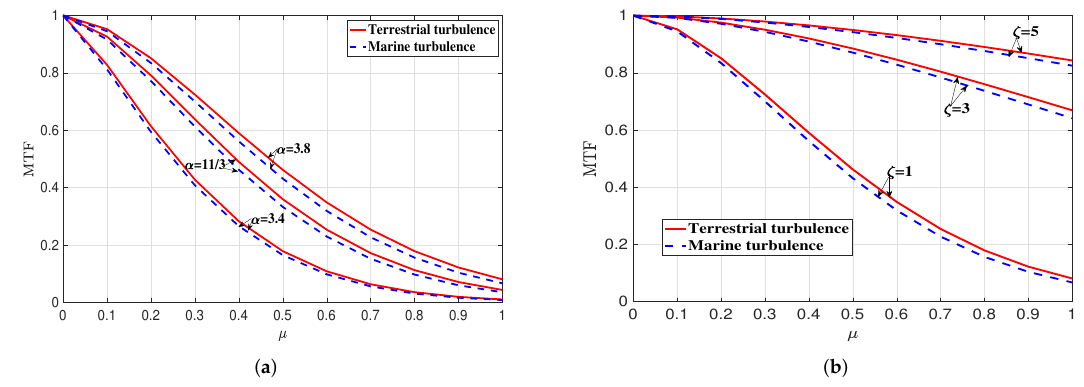
Figure 3. Long-exposure modulation transfer function (MTF) as a function of normalized spatial frequency for collimated Gaussian beam waves with various ( a ) power law exponent α and ( b ) anisotropic parameter